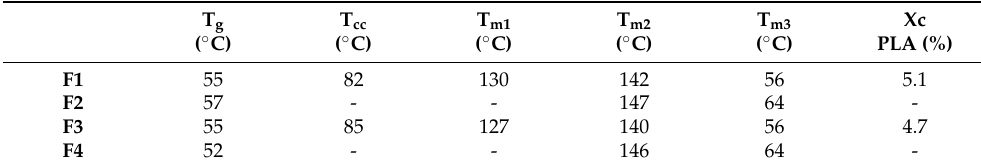
Table 2. Thermal properties of membranes PCL/PLA/ZnO-NPs/Gly/TTEO. F1, 25%PCL/70%PLA/ 5%Gly; F2, 22%PCL/70%PLA/5%Gly/3%ZnO-NPs; F3, 15%PCL/70%PLA/5%Gly/10%TTEO; F4, 17%PCL/70%PLA/5%Gly/3%ZnO-NPs/10%TTEO.